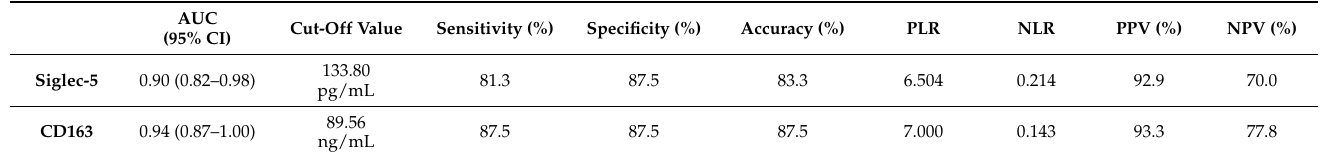
Figure 4. Diagnostic performance evaluation of plasma Siglec-5 and CD163 for FM using the ROC curve analysis. Receiver operating characteristic (ROC) curves of plasma Siglec-5 ( A ) and CD163 ( B ) in 32 patients with FM and 16 control individuals. AUROC indicates the area under the receiver operating characteristic. Table 2. Diagnostic performance of Siglec-5 and CD163 to distinguish FM from control